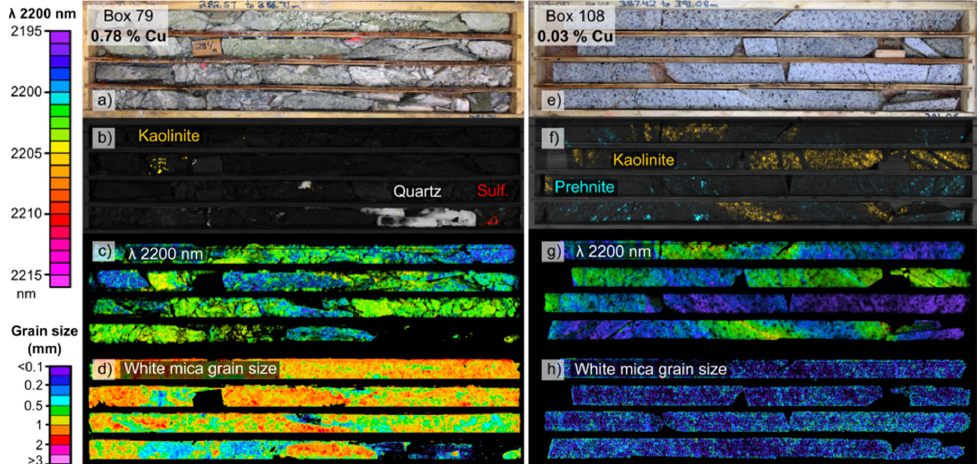
Figure 10. Left: Core box 79 from a mineralized interval. ( a ) Color photograph. Hyperspectral imagery processed to display; ( b ) the distribution of kaolinite (orange), quartz (white) and sulfides (red); ( c ) the position of the 2200 nm absorption feature; ( d ) white mica grain size. Right: Core box 108 from a barren interval. ( e ) Color photograph. Hyperspectral imagery processed to display; ( f ) the distribution of kaolinite (orange) and prehnite (blue); ( g ) the position of the 2200 nm absorption feature; ( h ) white mica grain size.